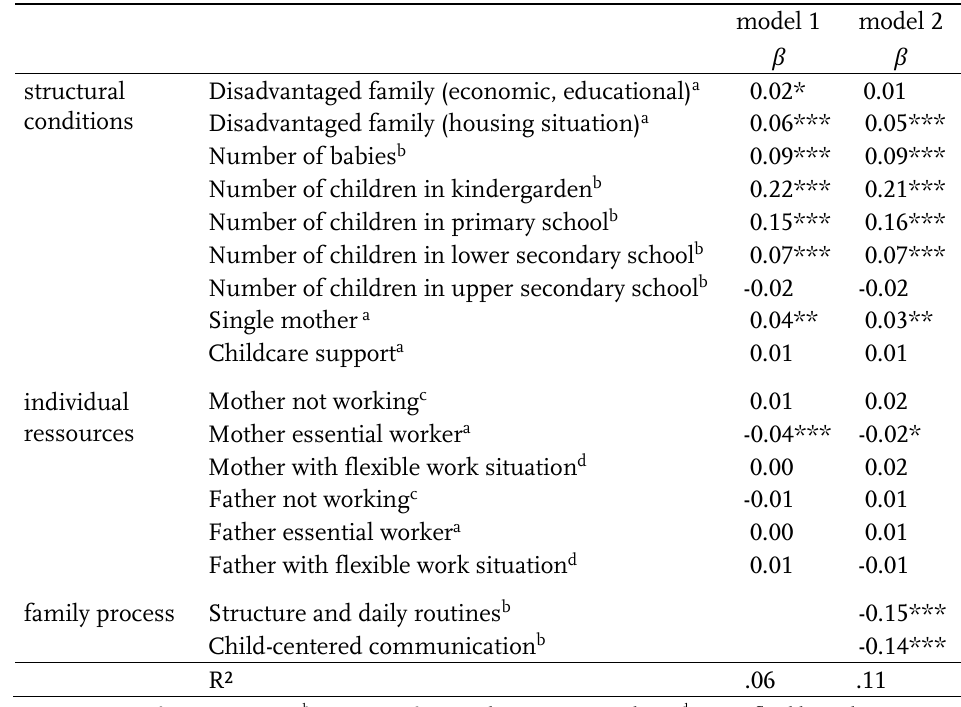
Table 4 Results of linear hierarchical regression analysis predicting a chaotic and conflictual family climate (standardized regression weights